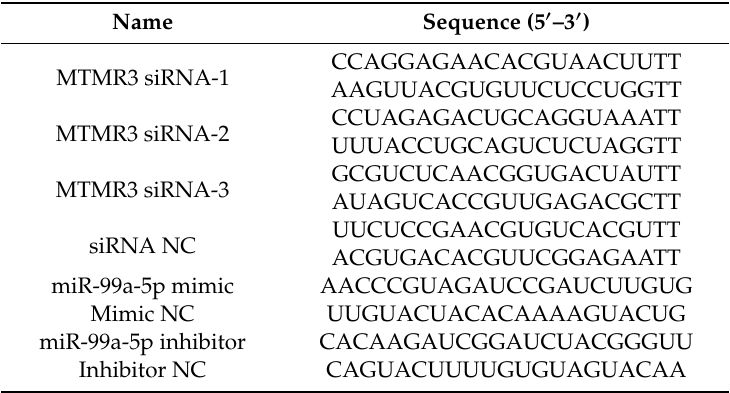
Table 1. RNA oligonucleotides in this study.